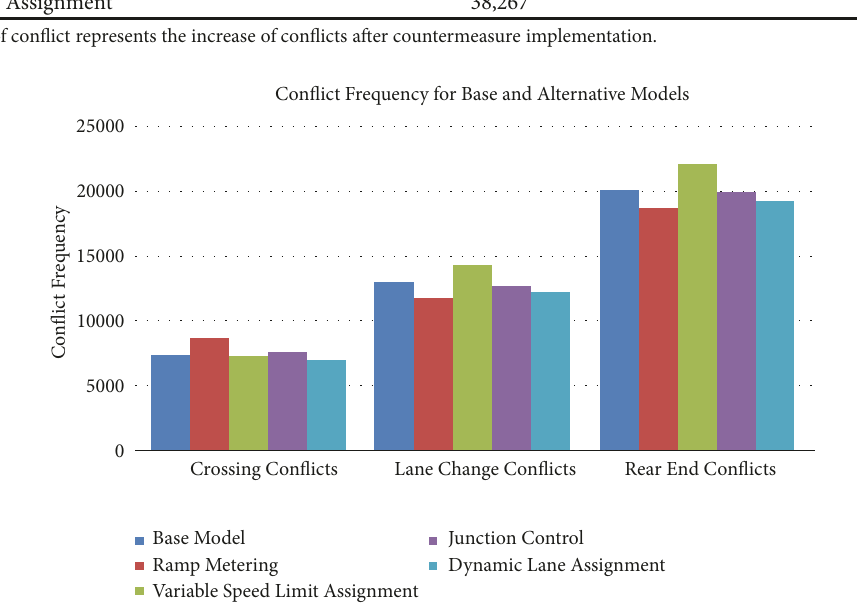
Figure 4: Conflict frequency for base model and proposed ITS